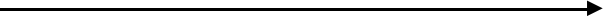
Fig. 1a. Yearly variations of the daytime (09:00–17:00 LT) averaged electron density at the magnetic equator and at magnetic latitudes 5 (cid:176) , 10 (cid:176) , 15 (cid:176) , 20 (cid:176) and 25 (cid:176) ; Southern Hemisphere ( solid curves ) and Northern Hemisphere ( dashed curves ). b Same as a except for the electron temperature